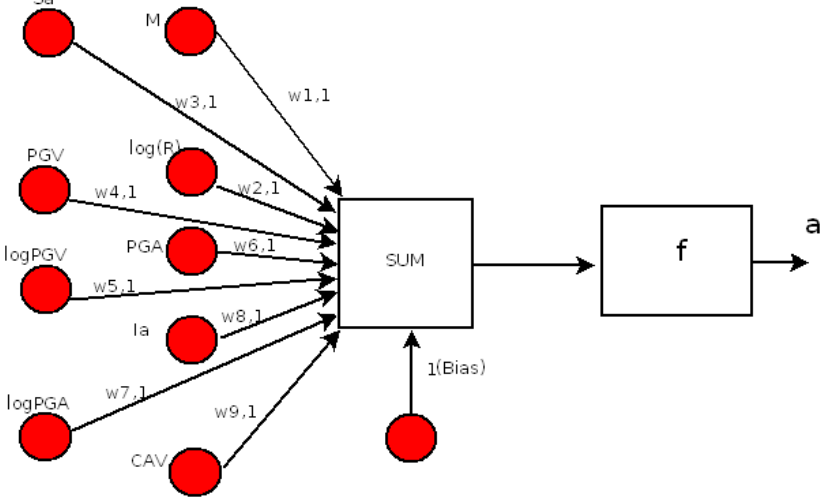
Fig. 4. Topology of the feed-forward k-NN-type ANN used in the present